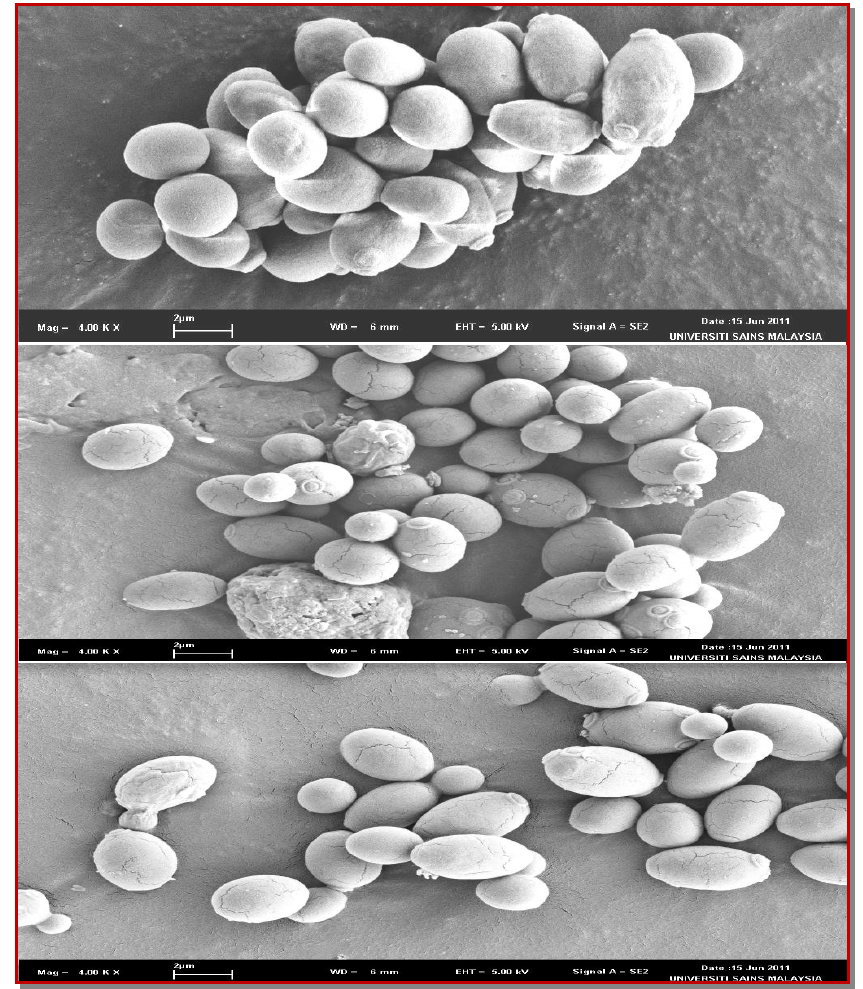
Figure I: SEM results for C. albicans cells treated with H. littoralis’s flower and root extract at MIC value. 1a: control; 1b and 1c: flower and root extract treated C. albicans at magnification of